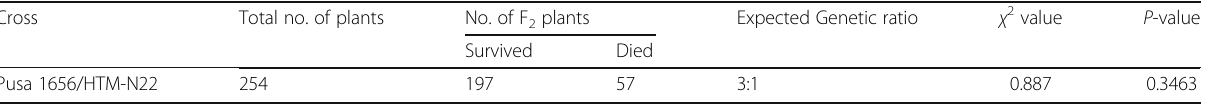
Table 1 Segregation pattern of herbicide tolerance in F 2 population from cross Pusa 1656/HTM-N22 Cross Total no. of